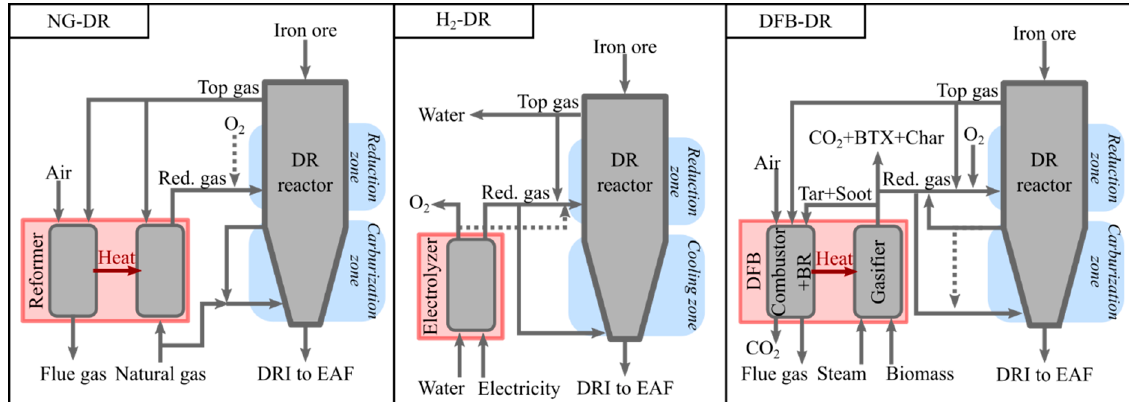
Figure 2. Schematic of the DR routes compared in this work. NG-DR refers to the traditional, natural-gas-based DR using the MIDREX technology, H 2 -DR refers to DR using hydrogen produced from electrolysis, and DFB-DR refers to the DR of iron using gas derived from DFB biomass gasification. The H 2 -DR and DFB-DR routes are based on a MIDREX DR reactor. Red. gas refers to the reducing gas, and BR refers to the bed reducer.